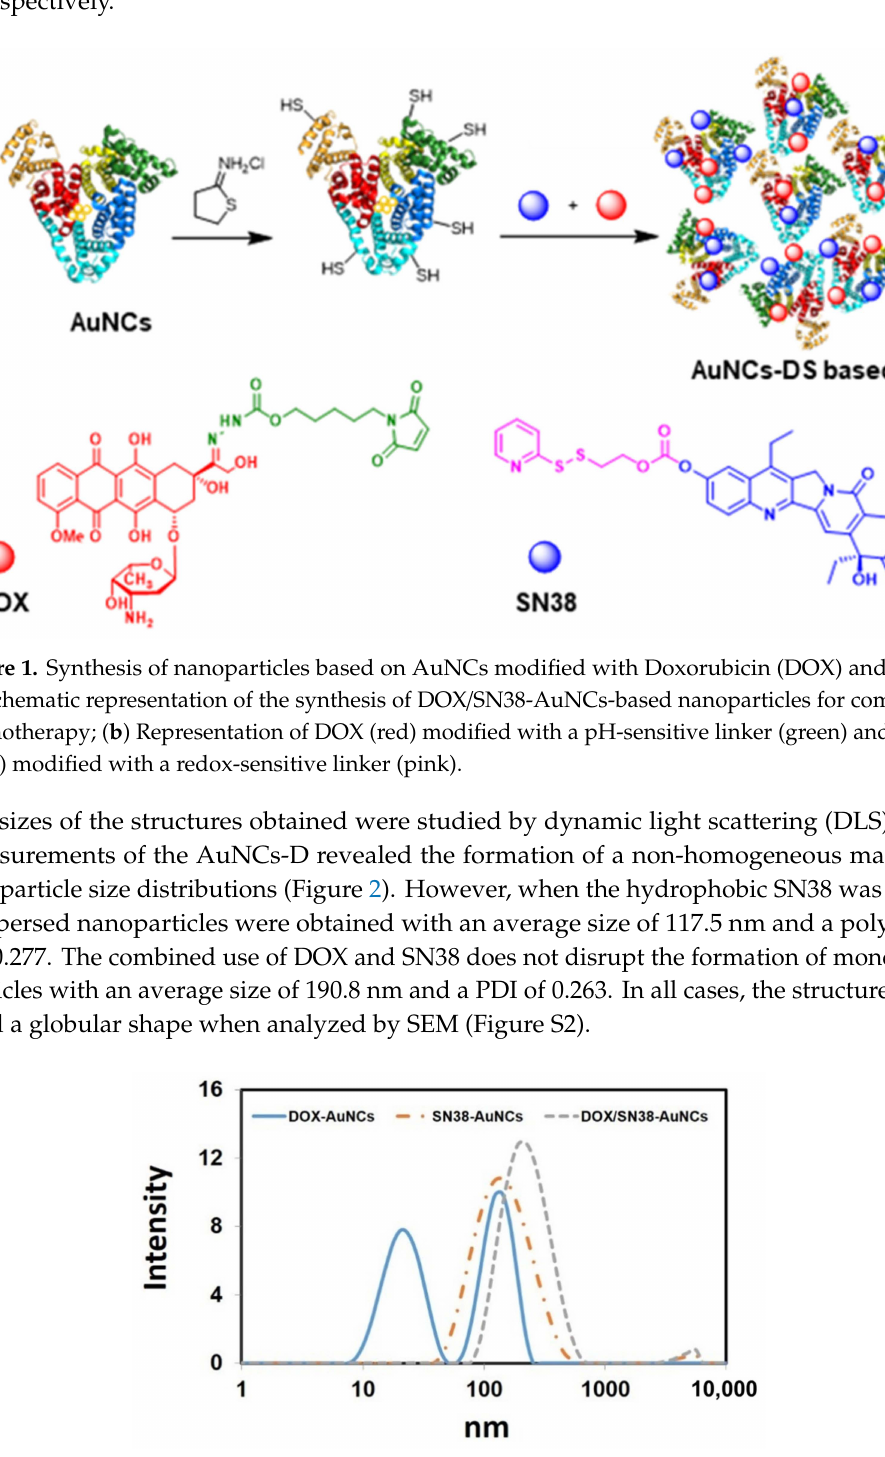
Figure 2. Size of Doxorubicin (DOX)-AuNCs, SN38-AuNCs and DOX / SN38-AuNCs measured by dynamic light scattering